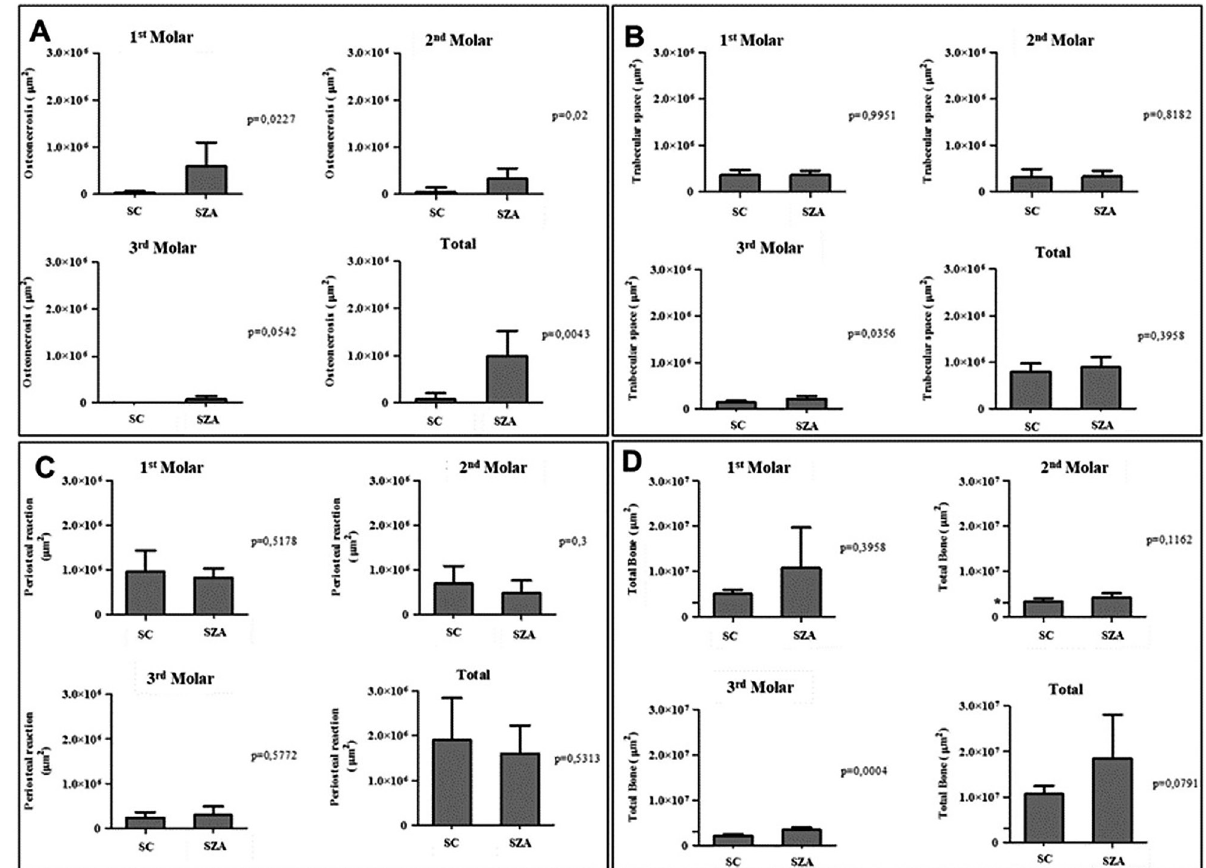
Figure 6- Graphs showing the areas of osteonecrosis (A), trabecular space (B), periosteal reaction (C), and total bone (D) in the regions of first, second, third molars and total area (sum of first, second, and third molars areas). The presented values represent means ± SD per group and area of each tooth. * Indicates the level 3.0 x 106 in the scale of total bone graphs, so that it can be compared with the graphs of the other studied variables. (*)= Kruskal-Wallis